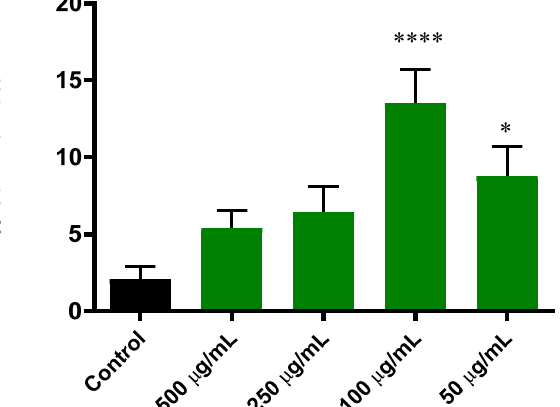
Figure 4. Effect of B. officinalis flower extract on the response to lethal oxidative stress induced by juglone (150 µ M) on C. elegans N2. Differences compared to control group were considered significant at p ≤ 0.05 (*) and p ≤ 0.0001 (****).